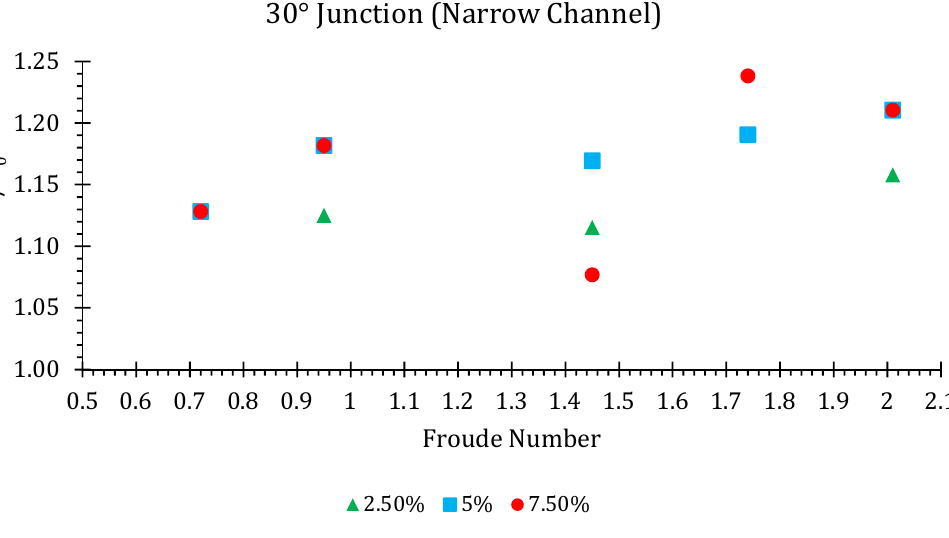
Figure 15. Maximum water height ratios in a 30° junction (narrow channel).